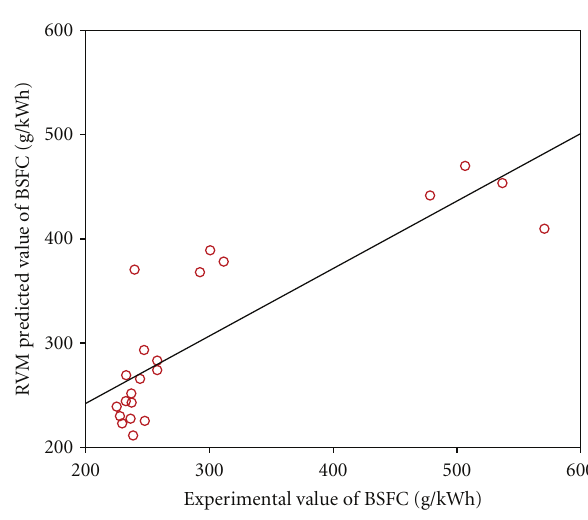
Figure 3: Comparison between RVM predicted values and the cor- responding actual values for